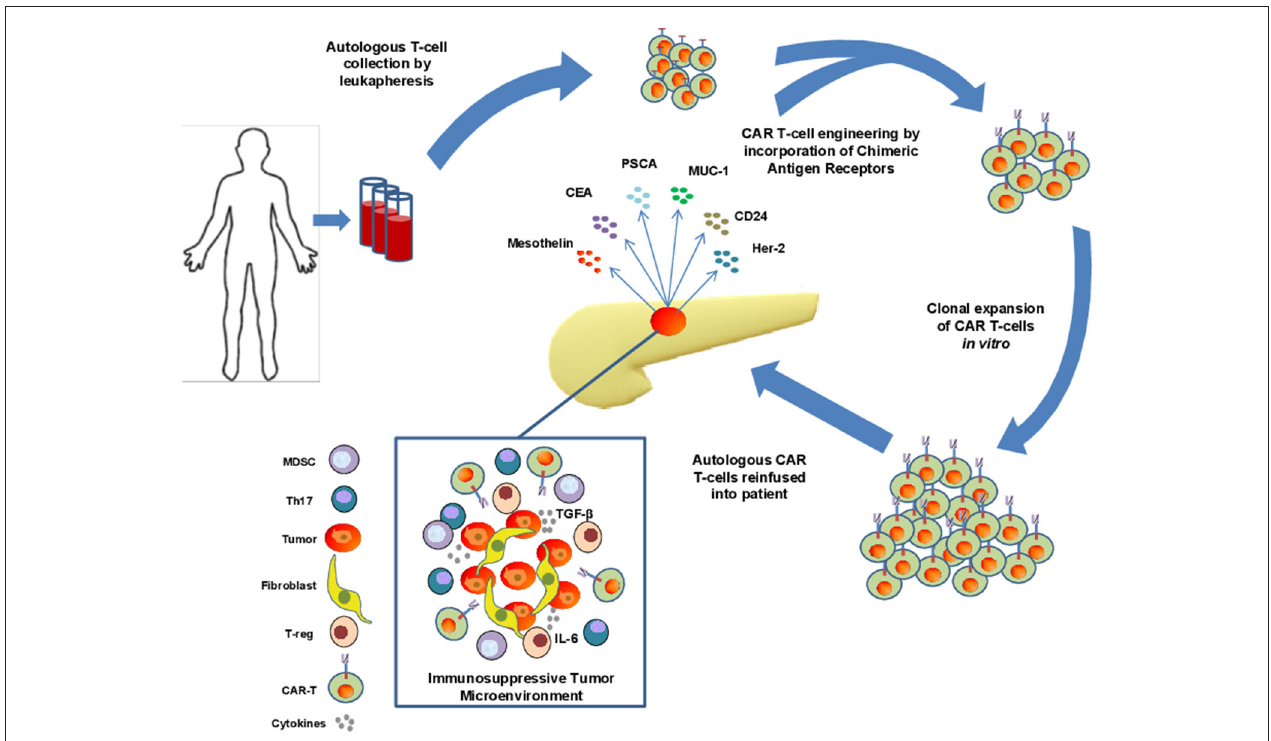
FIGURE 1 | Isolation, engineering, and challenges of CAR T cell therapy in pancreatic adenocarcinoma (PDAC). T cells are collected from peripheral blood of patients with PDAC via leukapheresis and engineered to express chimeric antigen receptors directed toward a specific tumor antigen. These cells are subsequently expanded before reinfusion into patients. Significant challenges exist for these cells to infiltrate the immunosuppressive tumor microenvironement of PDAC including the presence of dense stroma and myofibroblast cells, immunosuppressive cytokines such as IL-6 and TGF- β , and the presence of immunosuppressive immune cell types such as Th17 cells, MDSCs, and suppressive